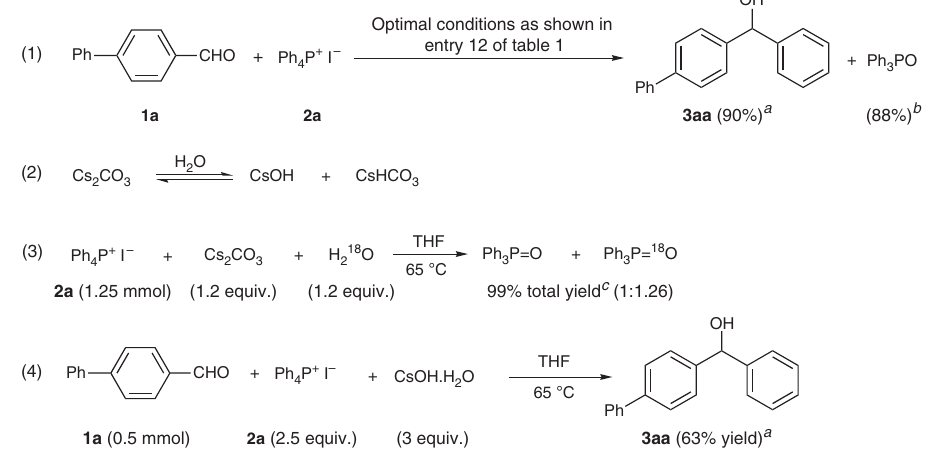
Figure 3 | Evidence to support the path via alkaline hydrolysis. (1) Ph 3 PO was isolated as a by-product for phenylation reaction. a Isolated yield based on 1a ; b Isolated yield based on 2a ; (2) An equilibrium between Cs 2 CO 3 and CsOH may be established under the reaction conditions. (3) The presence of H 2 18 O led to the formation of Ph 3 P 18 O. c Isolated yield. (4) CsOH can also initiate the phenylation reaction.